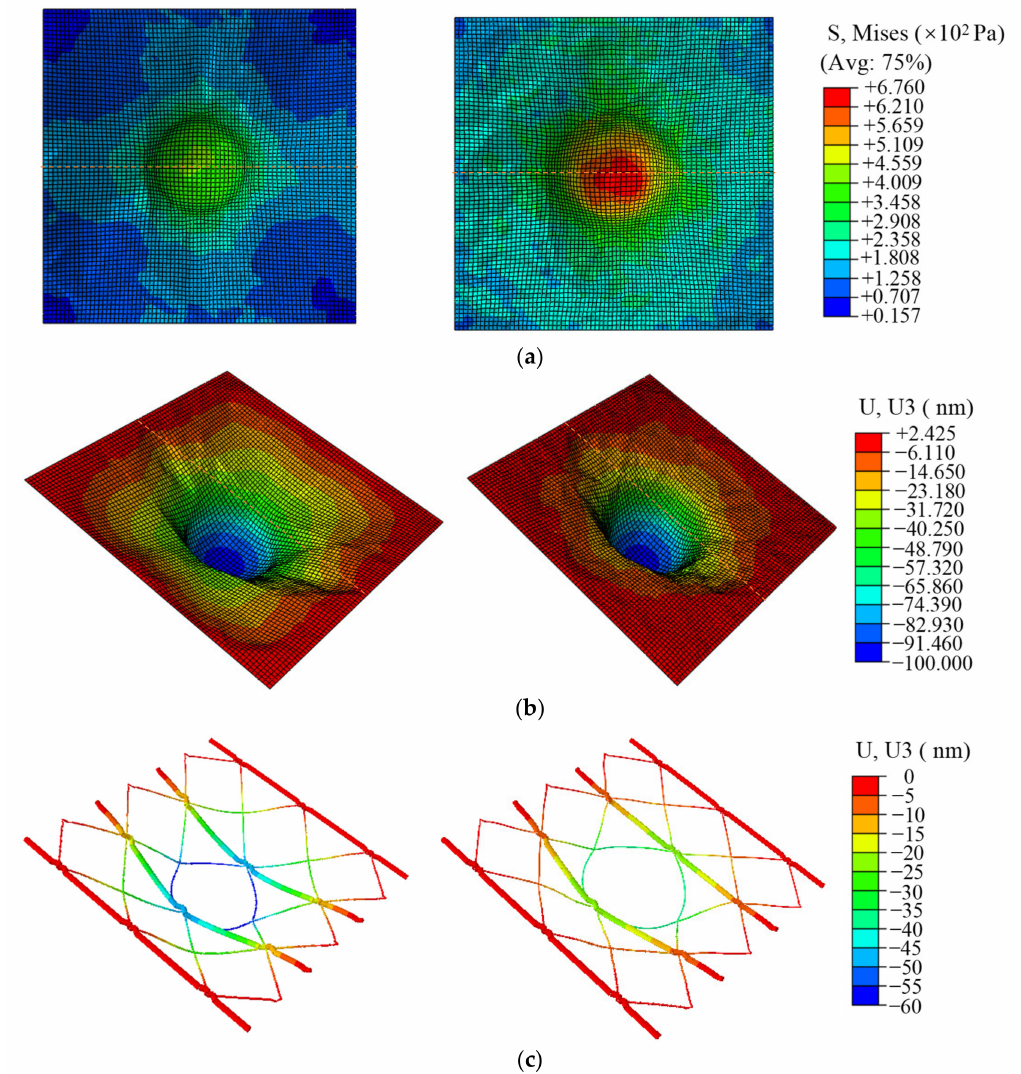
Figure 5. ( a ) The stress distribution of the cell membrane under the indentation depth of 100 nm in the absence ( left ) and presence ( right ) of prestressing. ( b ) The deformation of the cell membrane in the z-direction under the indentation depth of 100 nm in the absence ( left ) and presence ( right ) of prestressing. ( c ) The deformation of the cell actin filaments in the z-direction under the indentation depth of 100 nm in the absence ( left ) and presence ( right ) of